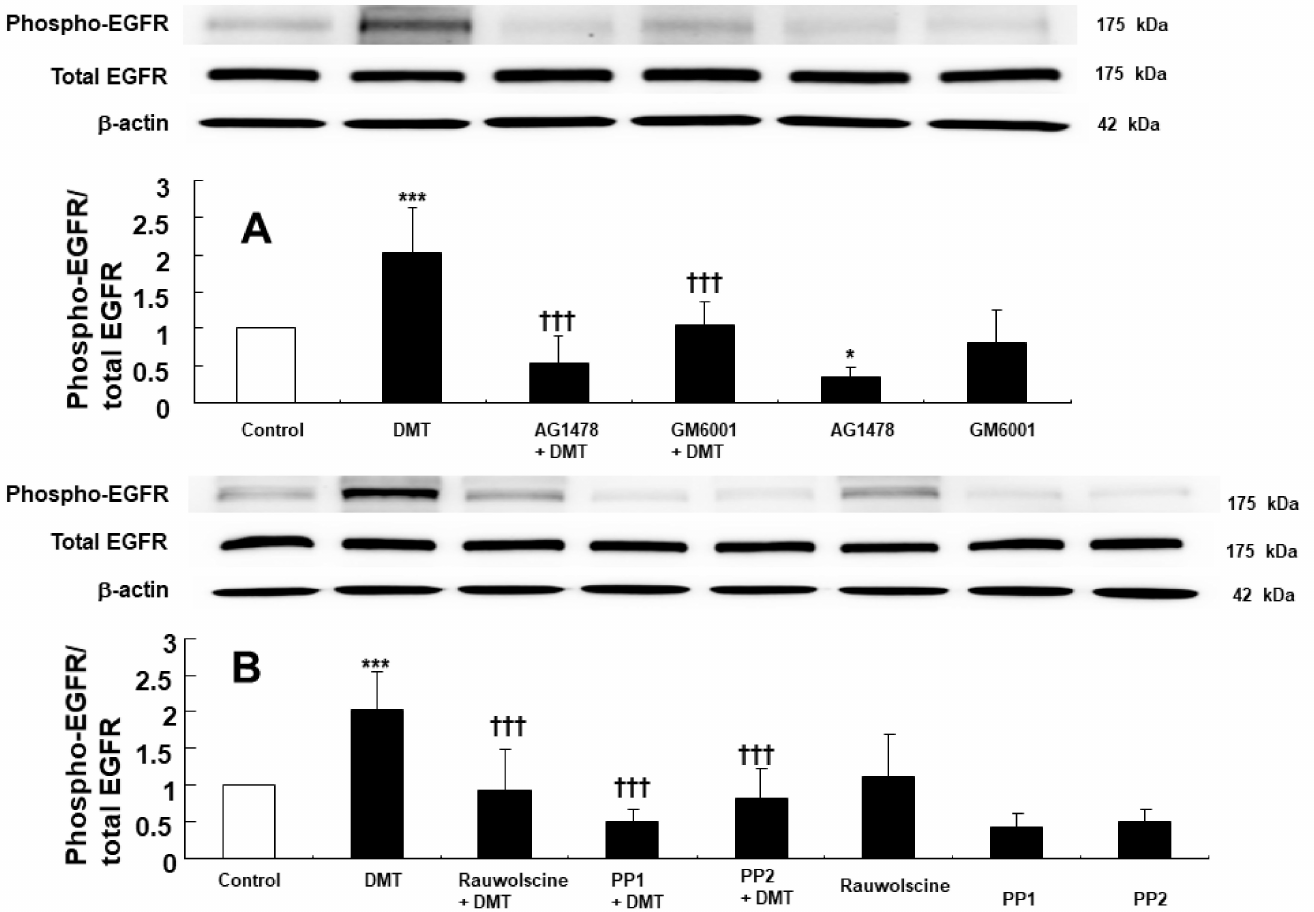
Figure 3. ( A ): Effects of AG1478 (10 − 5 M) and GM6001 (3 × 10 − 5 M) on dexmedetomidine (DMT, 10 − 6 M)-induced epidermal growth factor receptor (EGFR) phosphorylation (Tyr1068) in rat aortic vascular smooth muscle. Data (N = 6) are shown as mean ± SD. N indicates the number of inde- pendent experiments. Control indicates no treatment. * p < 0.05 and *** p < 0.001 versus control. ††† p < 0.01 versus DMT alone. (B): Effects of rauwolscine (10 − 6 M), PP1 (10 − 5 M), and PP2 (10 − 5 M) on the DMT-induced EGFR phosphorylation (Tyr1068) in rat aortic vascular smooth muscle. Data (N = 6) are shown as mean ± SD. N indicates the number of independent experiments. Control indicates no treatment. *** p < 0.001 versus control. ††† p < 0.01 versus DMT